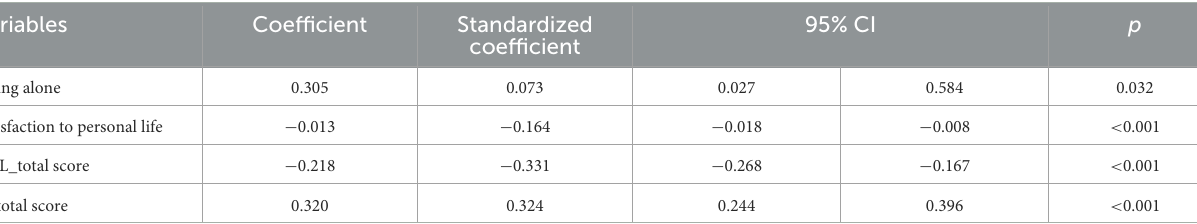
TABLE 4 Results of multiple linear regression analysis for depressive symptom